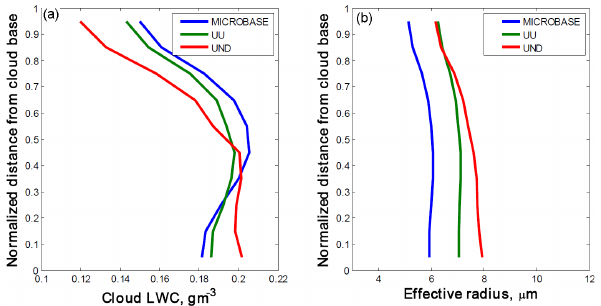
Fig. 9. MICROBASE, UU, and UND cloud LWC (a) and r e (b) as a function of normalized height for low-level non-raining liquid stratus from 1998 to